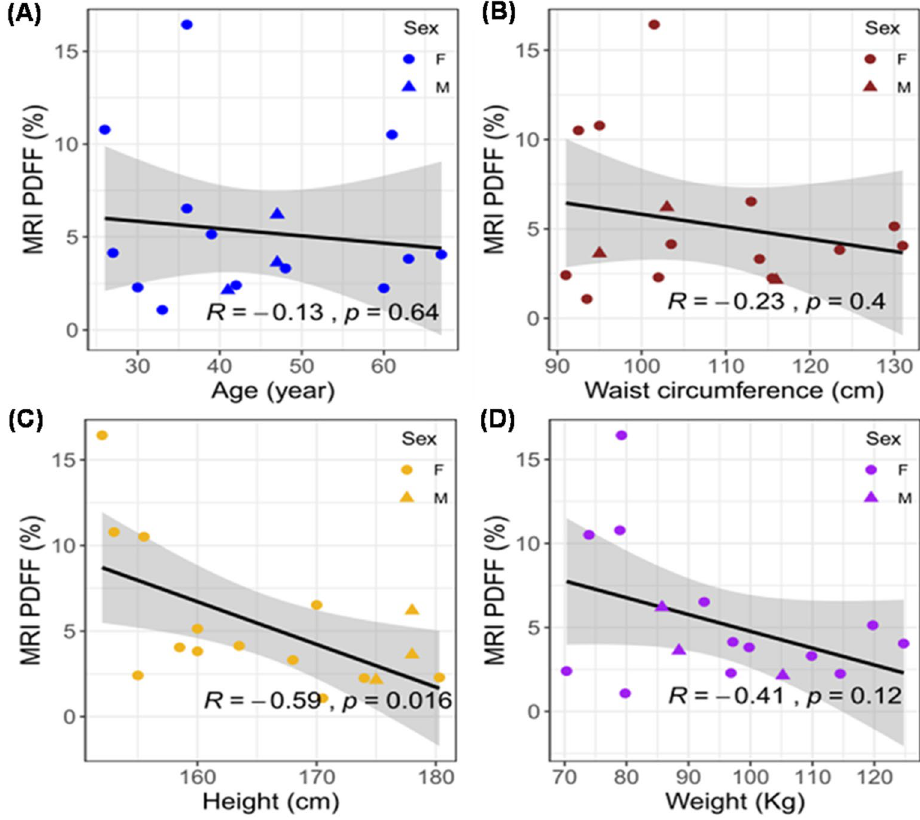
Figure 4. MRI PDFF vs. age, waist, height, and weight. The Pearson correlation coefficients ( R ) and p values were analyzed for (A) age, (B) waist circumference, (C) height, and (D) weight. The circles denote female subjects and triangles denote male subjects. The 95% confidence intervals of the linear slopes are illustrated as shaded area. R values are −0.13 for age ( p = 0.64, n = 16), −0.23 for waist circumference ( p = 0.4, n = 16), −0.59 for height ( p = 0.016, n = 16)., and −0.41 for weight ( p = 0.12, n = 16), demonstrating low to intermediate correlation with MRI